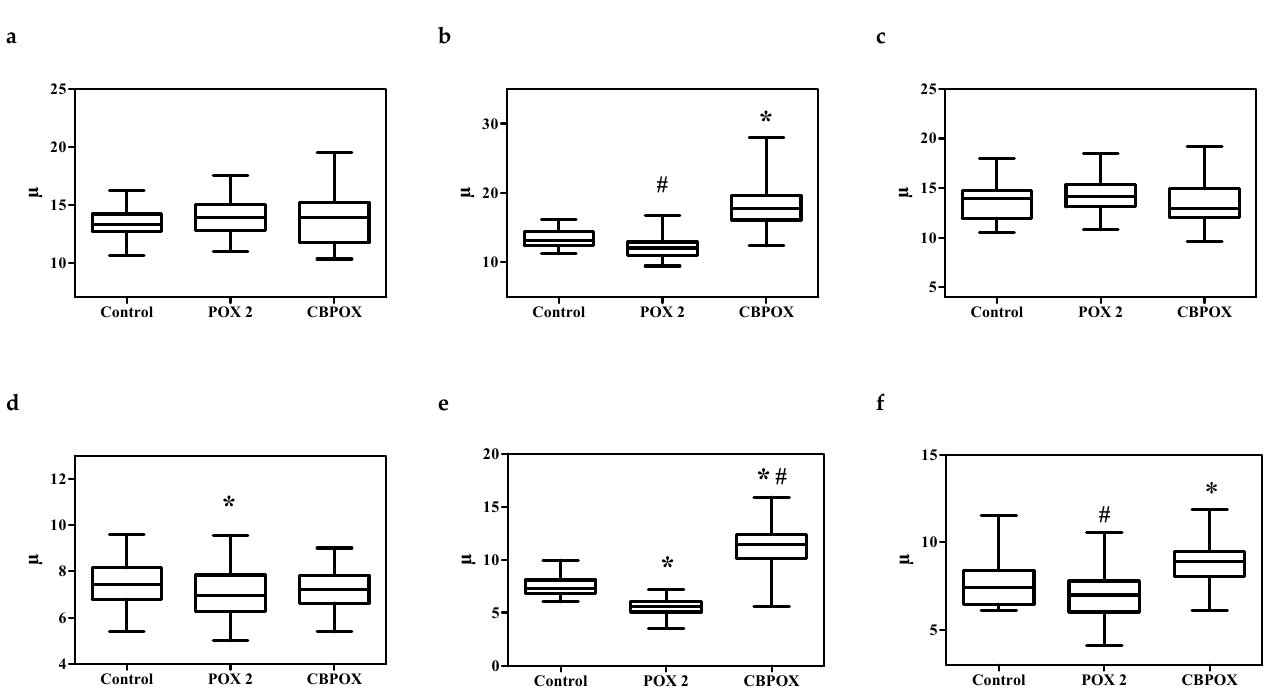
Figure 4. A ( a – c ). Diameter of proximal convoluted tubules (PCT), µm: ( a ) 1 day, ( b ) 3 days, and ( c ) 7 days exposure to POX. B ( d – f ). Lumen diameter of the proximal convoluted tubules (PCT), µm: ( d ) 1 day, ( e ) 3 days, and ( f ) 7 days after the exposure. * p ≤ 0.01 compared to the control group; # p ≤ 0.01 between the POX2x and CBPOX groups.